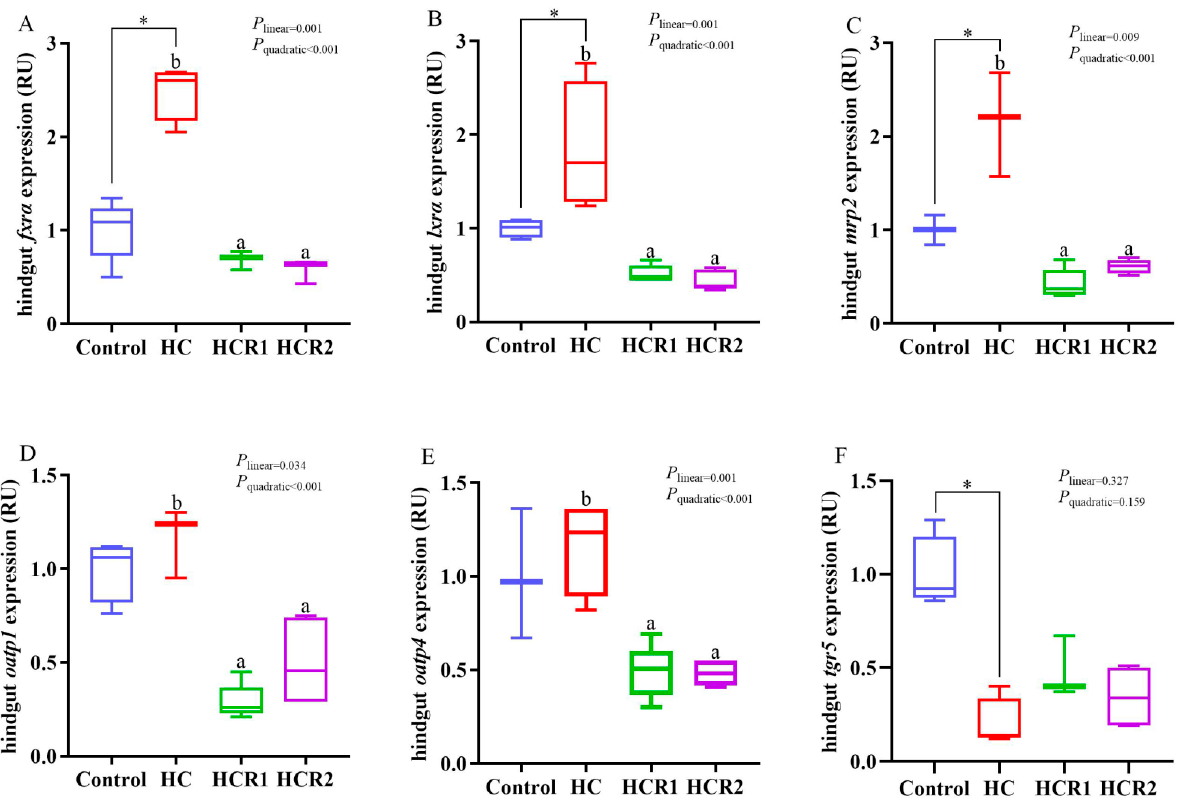
Figure 7. Relative transcriptions of the genes involved in cholesterol and bile acid metabolism in the hindgut. The mRNA levels of farnesoid X receptor α ( fxr α ) ( A ), liver X receptor α ( lxr α ) ( B ), multidrug resistance associated protein 2 ( mrp2 ) ( C ), organic anion-transporting polypeptide 1 ( oatp1 ) ( D ), organic anion-transporting polypeptide 4 ( oatp4 ) ( E ), takeda G-protein-coupled BA receptor ( tgr5 ) ( F ) were evaluated using real-time RT-PCR. Data are referred to the values (relative units, RU) obtained in fish fed the control diet. Each data point represents the mean of four replicates (4 individuals per replicate). * Means p < 0.05, compared between the control and the HC group. ab Compared among the HC, HCR1, and HCR2 groups. Bars assigned with different superscripts are significantly different ( p < 0.05). The first and third quartiles are represented by the top and bottom of the box, while the minimum and maximum values are represented by the whiskers. Control, diet with 32% nitrogen-free extract; HC, diet with 45% nitrogen-free extract; HCR1, diet with 45% nitrogen-free extract and 0.04% resveratrol; HCR2, diet with 45% nitrogen-free extract and 0.08%